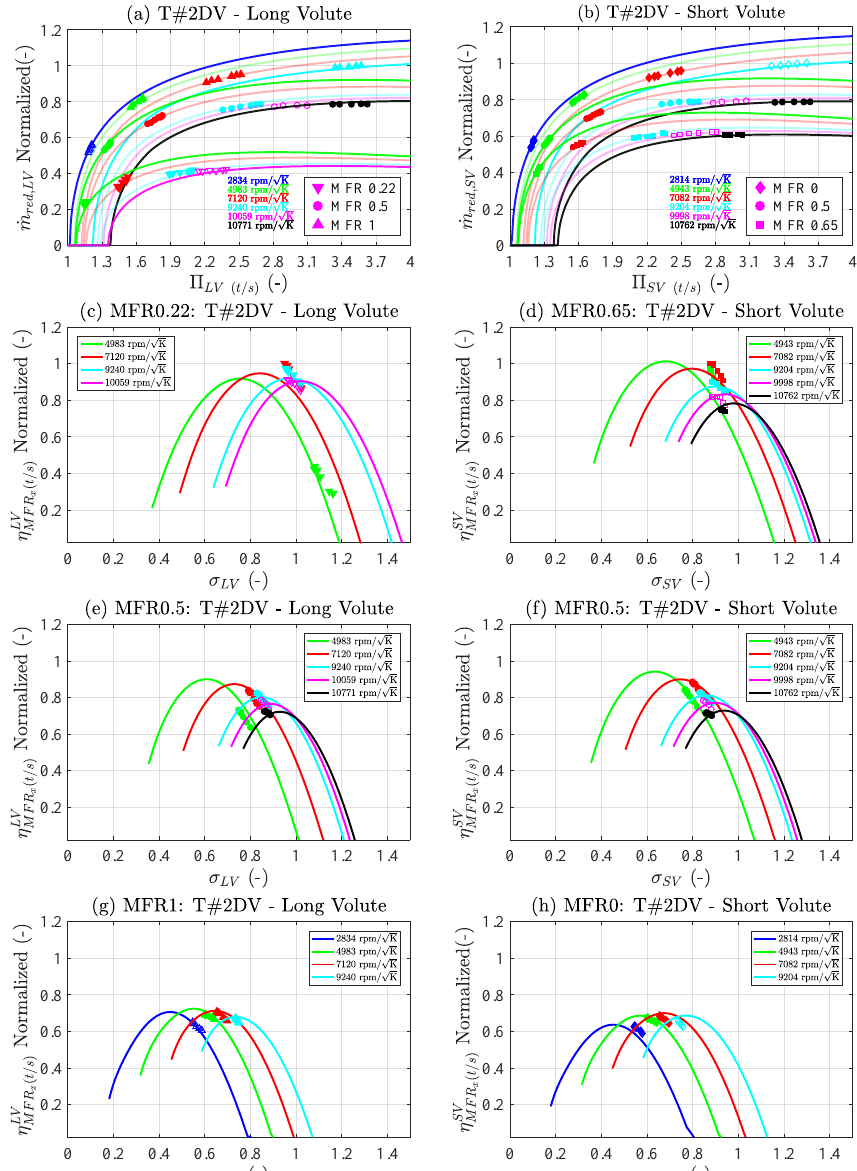
Figure 27. Dual-volute turbine reduced mass flow and apparent efficiency extrapolation for both volutes using only the filled points fitting coefficients. Non-filled points are predicted by the